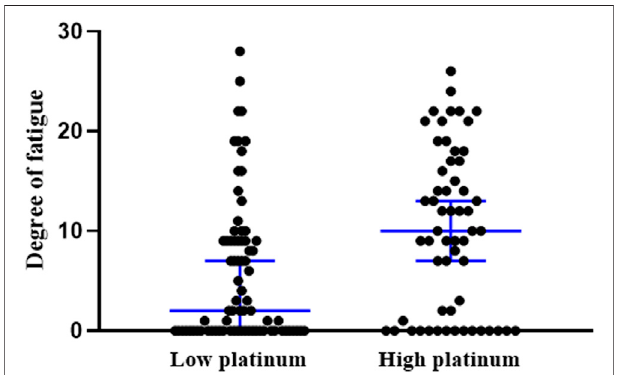
FIGURE 3 | Scatter plot on the degree of fatigue in low- and high- platinum groups. * *:p < 0.01.